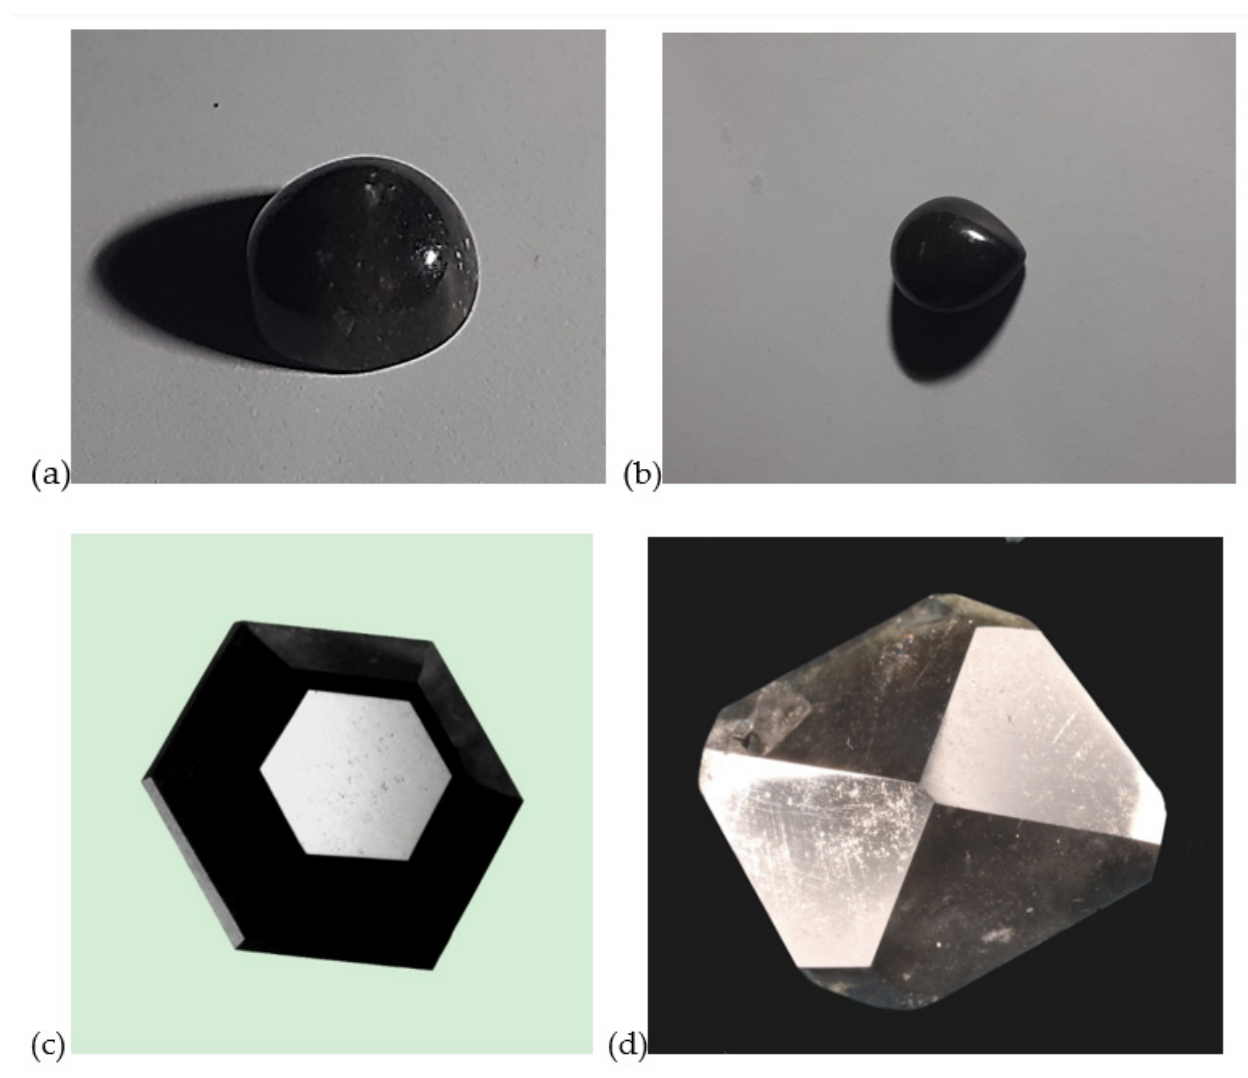
Photo by Enrico Borghi.